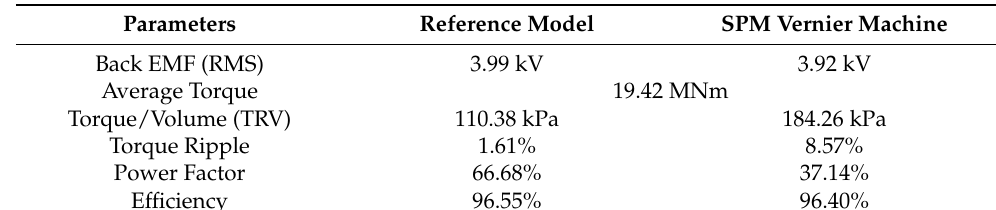
Table 2. Performance Summary.